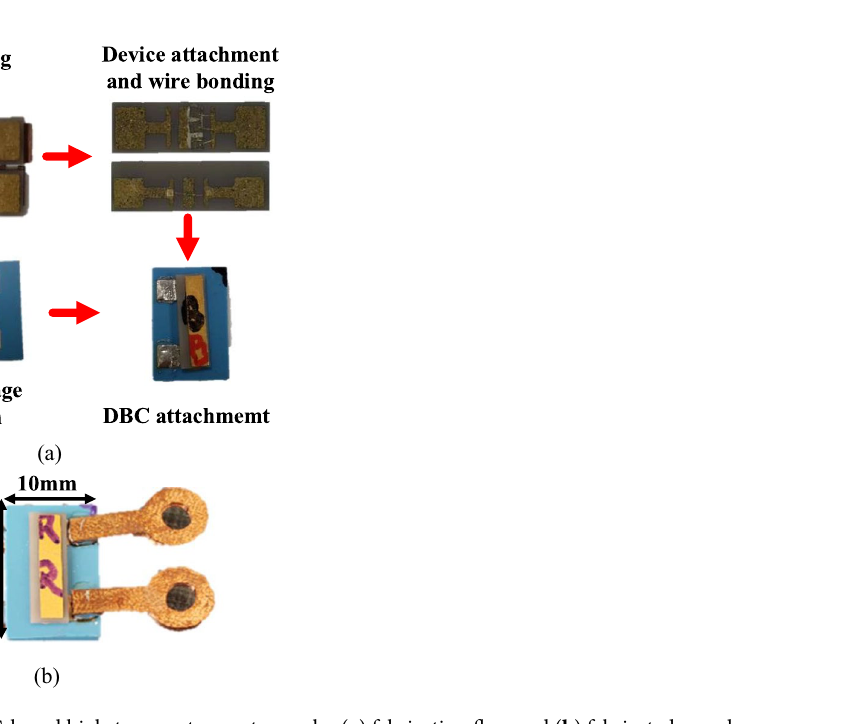
Figure 2. LTCC-based high-temperature optocoupler ( a ) fabrication flow and ( b ) fabricated